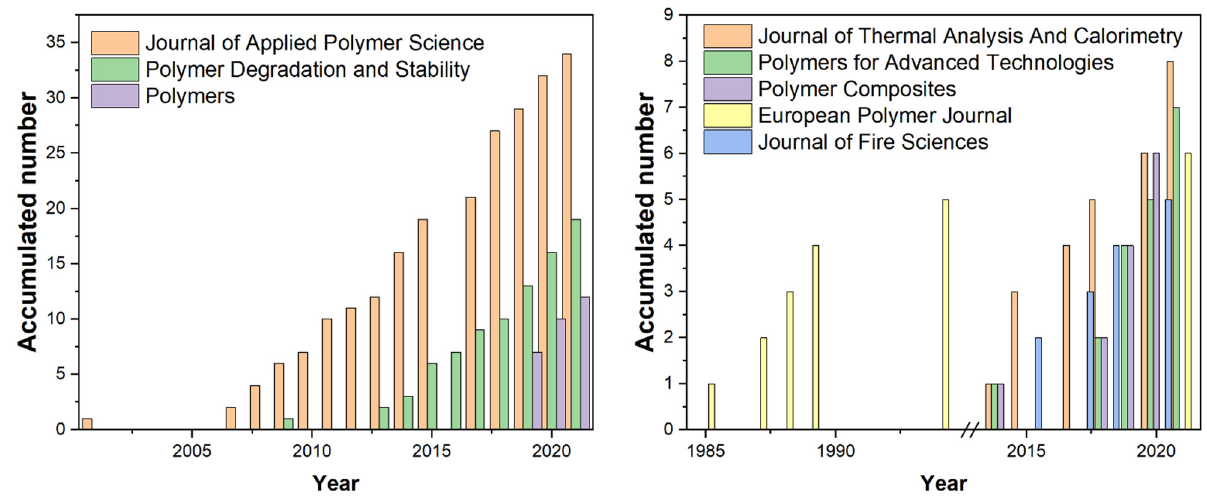
Figure 4. Time-dependent, cumulative number of publications of journals in Figure 3 related to flame-retardant RPUF.